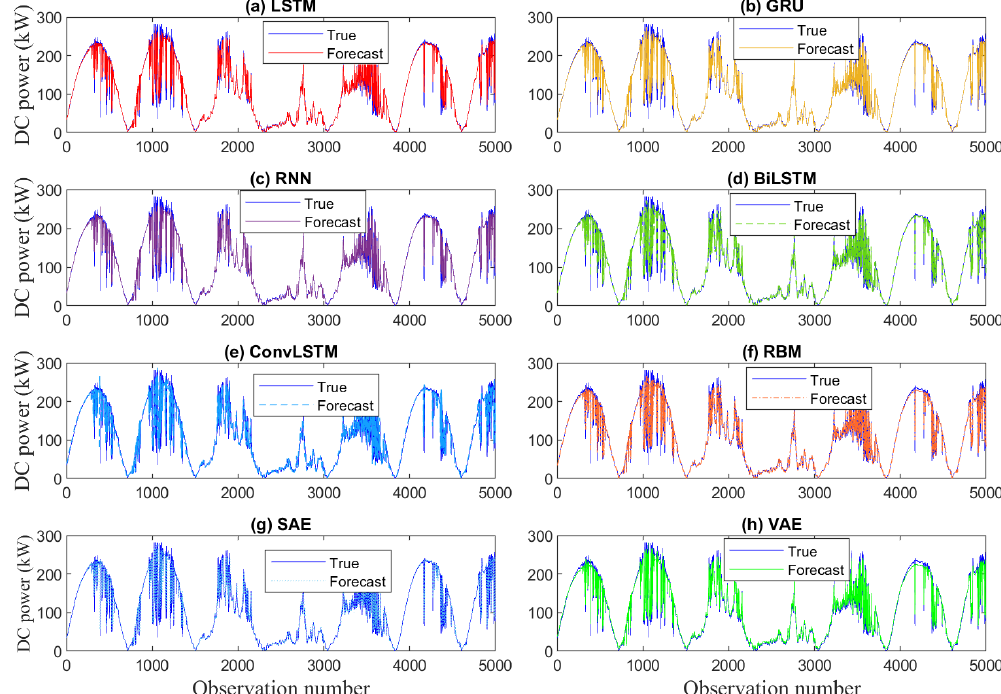
Figure 7. Forecasting results from the eight models using the testing datasets: ( a ) Long Short-Term Memory Networks (LSTM), ( b ) gated recurrent unit (GRU), ( c ) recurrent neural network (RNN), ( d ) Bidirectional LSTM (BiLSTM), ( e ) Convolutional LSTM (ConvLSTM), ( f ) Restricted Boltzmann Machine